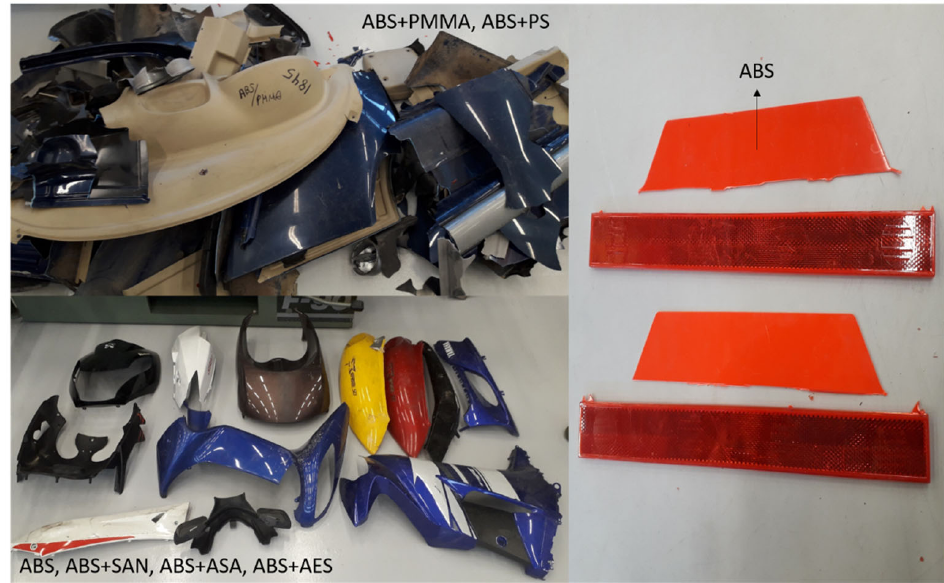
Figure 1. Scrap polymers from various automotive parts.